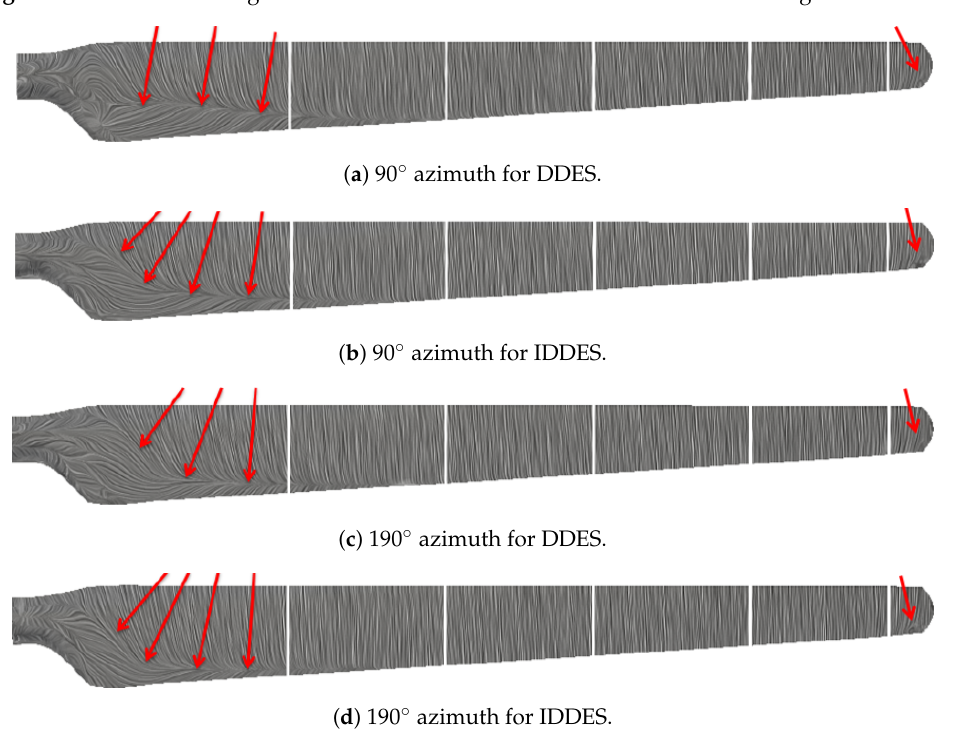
Figure 10. Normal and tangential force coefficients for three different sections along a blade radius.